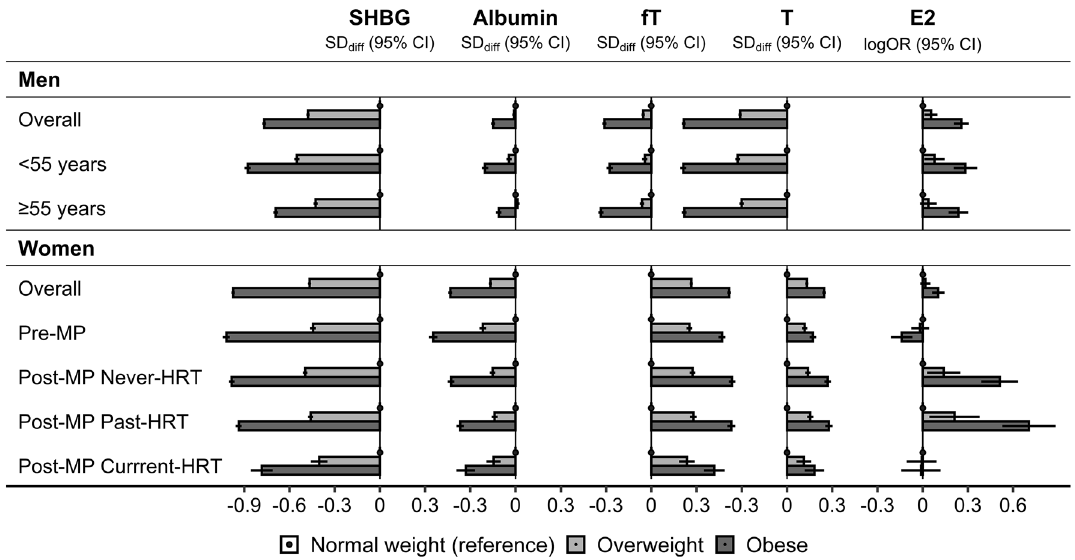
Figure 2. Associations of body size with sex steroids and their binding proteins. BMI body mass index, E2 oestradiol, fT free testosterone, HRT hormone replacement therapy, Normal weight BMI ≥ 18.5 to < 25.0 kg/ m 2 , Obese BMI ≥ 30 to < 45 kg/m 2 , Overweight BMI ≥ 25 to < 30 kg/m 2 , Post-MP post-menopausal, Pre-MP pre-menopausal, SHBG sex hormone binding globulin, T total testosterone, SD diff ( 95% CI ) estimates for standard deviation differences (95% confidence interval) were obtained from multivariable linear regression models including SHBG, albumin, T, or fT on a continuous standard deviation scale (sex-specific z-scores) as an outcome variable and as independent variables BMI categories and covariates, logOR ( 95% CI ) estimates for odds ratios of oestradiol detection (95% confidence interval) were obtained from multivariable logistic regression models (logOR corresponds to the linear predictor or the model). Covariates included an ABSI- by-HI cross-classification, height, age at enrolment, weight change within the last year preceding enrolment, smoking status, alcohol consumption, physical activity, Townsend deprivation index, region of the assessment centre, time of blood collection, fasting time, use of cholesterol lowering drugs (except Pre-MP), and in women also age at the last live birth, oral contraceptives use with time since stopped, bilateral oophorectomy (except Pre-MP) and, additionally, menopausal status and HRT use and duration (women overall), time of the menstrual period (Pre-MP), time since stopped and duration of HRT use (Past-HRT), or duration of use and type of HRT (Current-HRT). Participant groups are defined in Supplementary Fig. S1. Covariates are defined in Supplementary Methods. Numerical values are shown in Supplementary Table